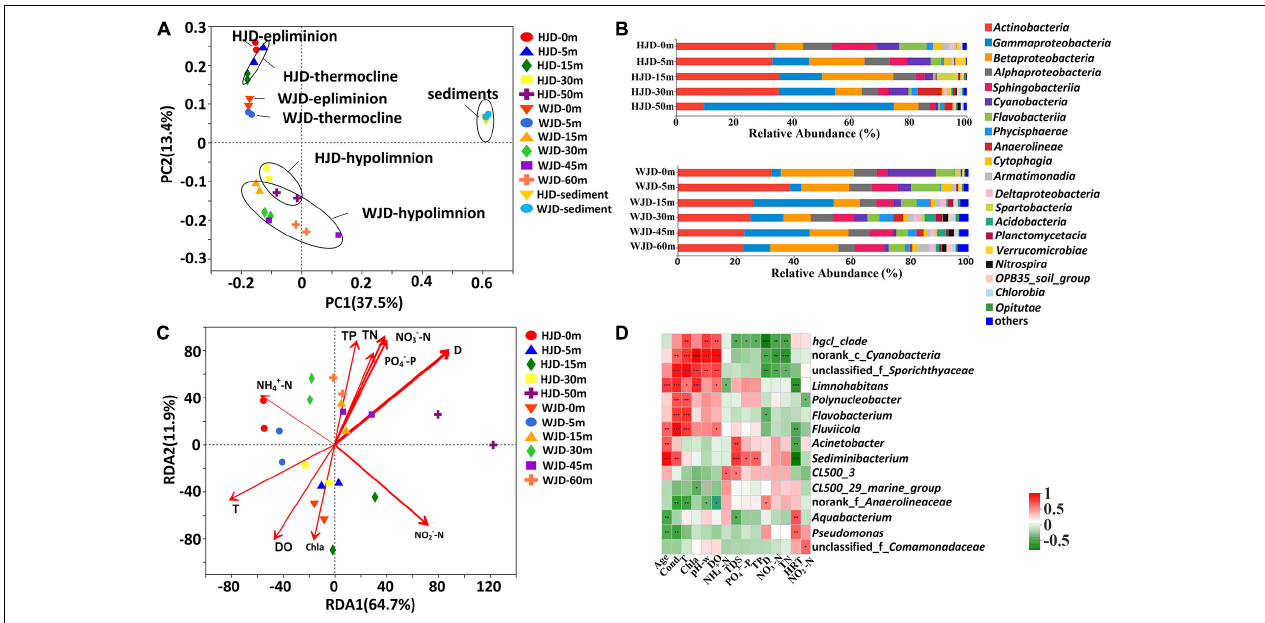
FIGURE 3 | Beta diversity analysis, taxonomical distribution, and redundancy analysis (RDA) of the bacterial community composition in Hongjiadu (HJD) and Wujiangdu (WJD) reservoirs. (A) Principal coordinates analysis (PCoA) of each sample at the OTU level based on the unweighted-unifrac matrix between samples. Percentages of the variation explained by each axis are indicated on the figure. Different circles represent the samples that were collected from the different groups. (B) The relative abundance of bacteria at class level in water samples. Only the classes that have relative abundance > 1% are shown. (C) RDA biplot of the community composition and environmental variables in water. The red arrows denote the environmental variables, including D (water depth), DO (water dissolved oxygen), T (water temperature), Chla (water Chlorophyll a), NO 3 − -N (water nitrate), NH 4 + -N (water ammonium), NO 2 − -N (water nitrite), TN (water total nitrogen), TP (water total phosphorus) and PO 43 − -P (water orthophosphate). (D) Heatmap of environmental factors affecting bacterial community structure at genus level among reservoir water samples. D (water depth), DO (water dissolved oxygen), T (water temperature), Chla (water Chlorophyll a), NO 3 − -N (water nitrate), NH 4 + -N (water ammonium), NO 2 − -N (water nitrite), TN (water total nitrogen), TP (water total phosphorus) and PO 43 − -P (water orthophosphate) were measured in